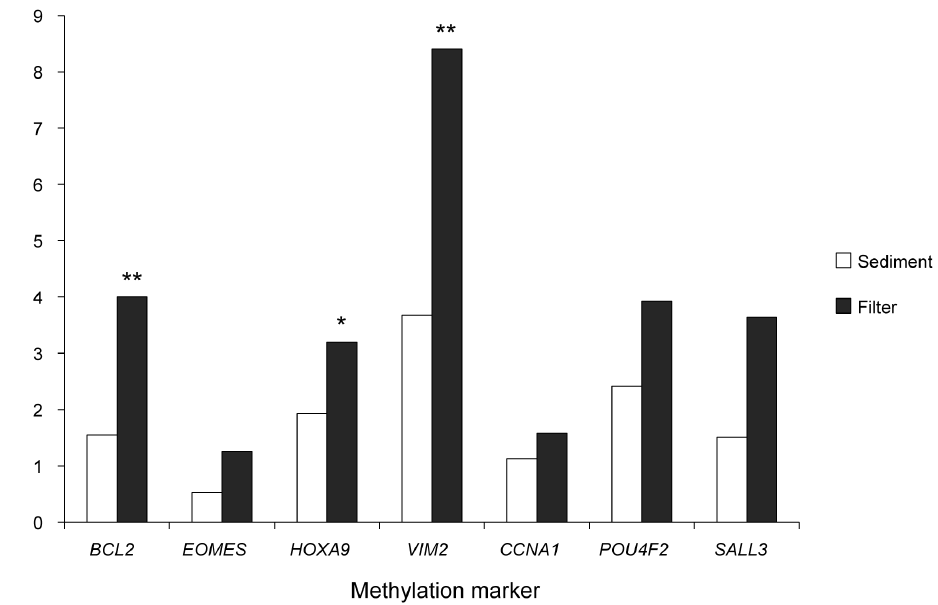
Figure 4. Levels of DNA methylation in paired urine samples (sediment and filter) from patients with bladder cancer (N=189). Shown is the median of normalized values (percent methylated reference, PMR) from MethyLight analysis of seven methylation markers. For each marker, the methylation levels ranged from , 1% to 100% (not shown). *, p , 0.05; **, p , 0.01.